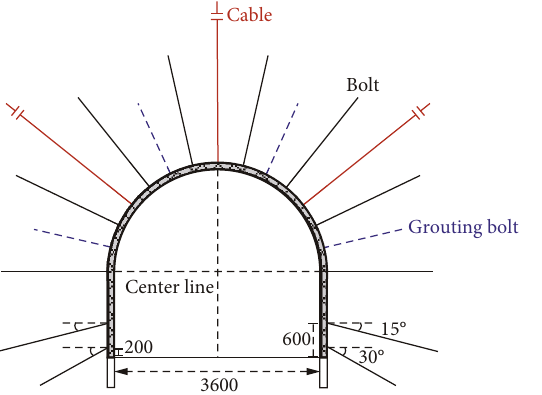
Figure 9: Supporting design of track rise.